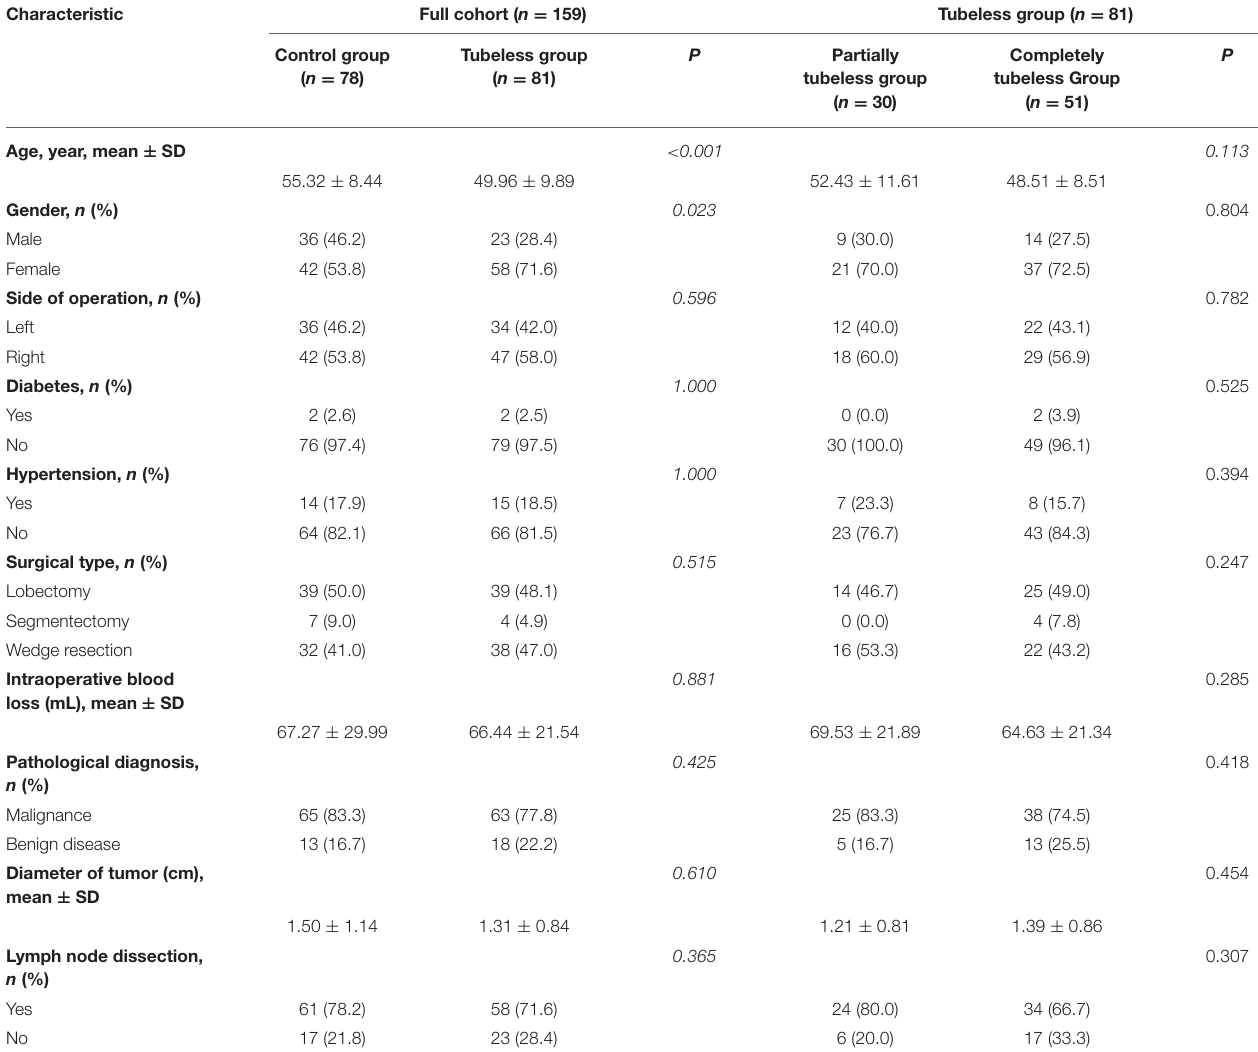
TABLE 1 | Baseline characteristics of the study population.